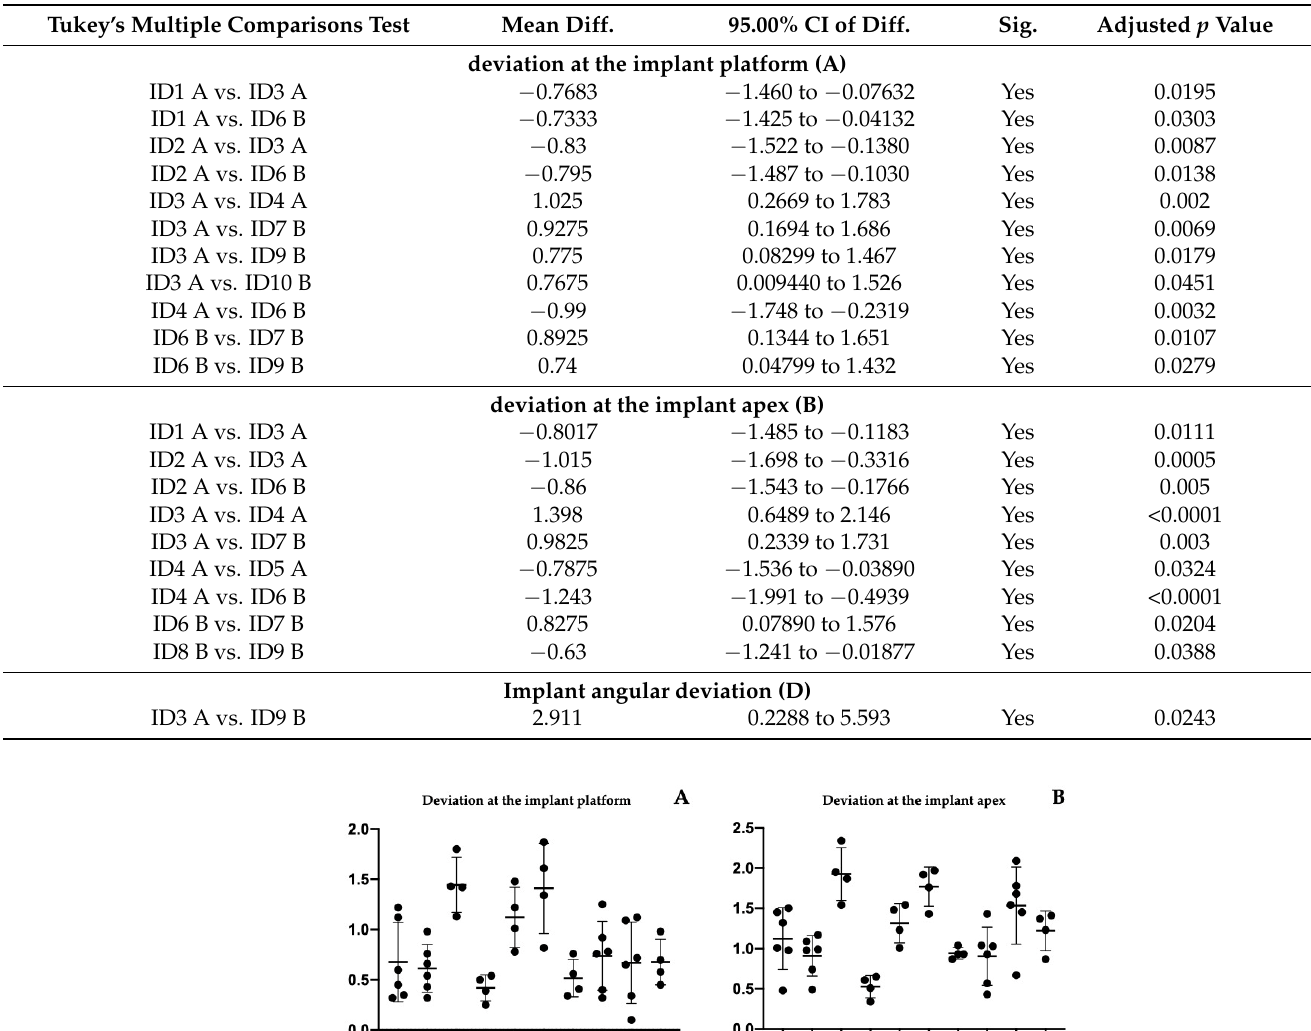
Table 4. Tukey multiple comparisons between patients. The only significant results are reported here. In all cases, differences emerged between maxillary and mandibula rehabilitation.